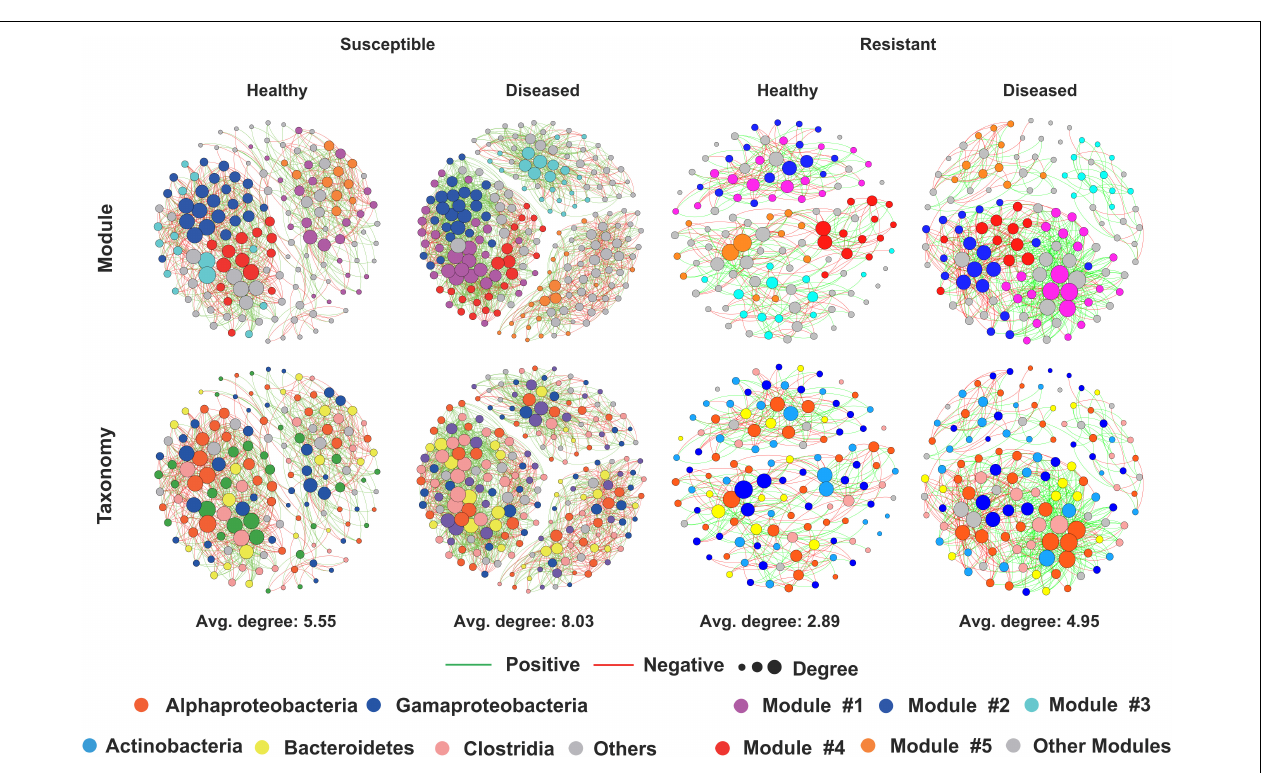
FIGURE 2 | Network visualization of the interaction architecture in bacterial community of healthy and diseased cotton